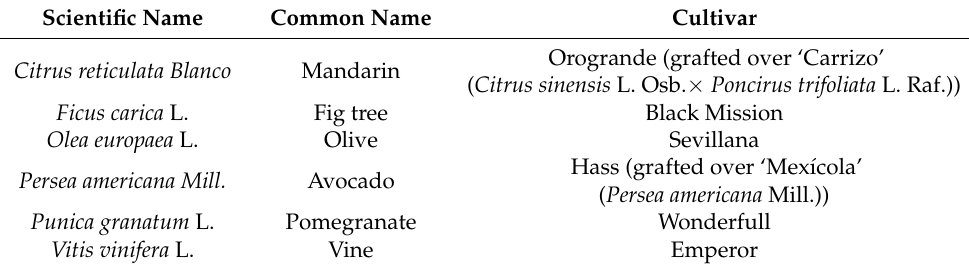
Table 1. Species, cultivars, and rootstocks were included in the trial. Scientific Name Common Name Cultivar